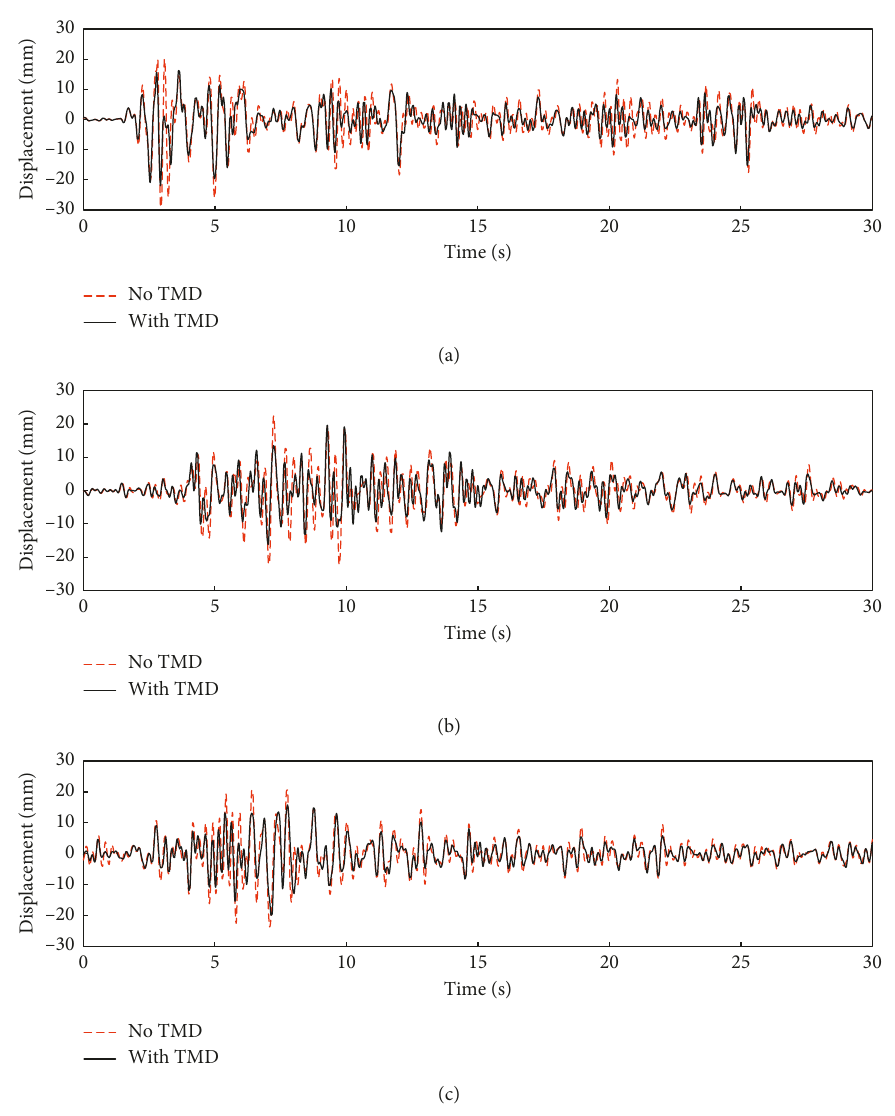
Figure 12: Displacement responses of the platform subjected to the three earthquake-induced seismic waves by experiment. Displacement time series under the (a) El-Centro NS seismic wave, (b) Taft EW seismic wave, and (c) Fukushima NS seismic